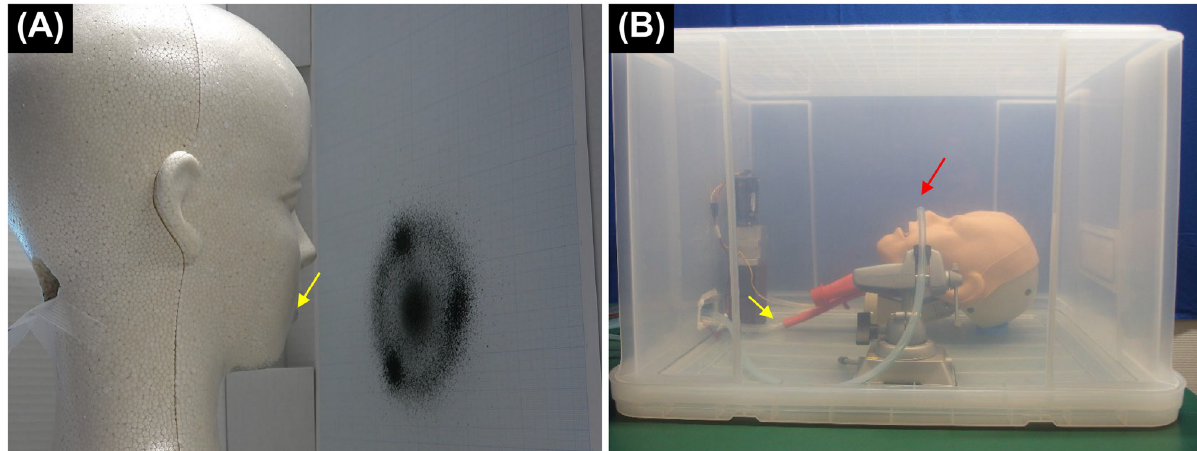
Fig 3. Simulated droplet and aerosol replication models. (A) A sprayer was installed in the mouth of the head model (yellow arrow) and ink was sprayed. The paper onto which the ink was sprayed was imaged, and the number of pixels that became black after binarization was measured. (B) The airway management training model was placed inside the plastic case and the smoke from an e-cigarette was sprayed through a tube from outside the plastic case (yellow arrow). The number of aerosol particles diffused into the plastic case was measured with a particle counter (red arrow).